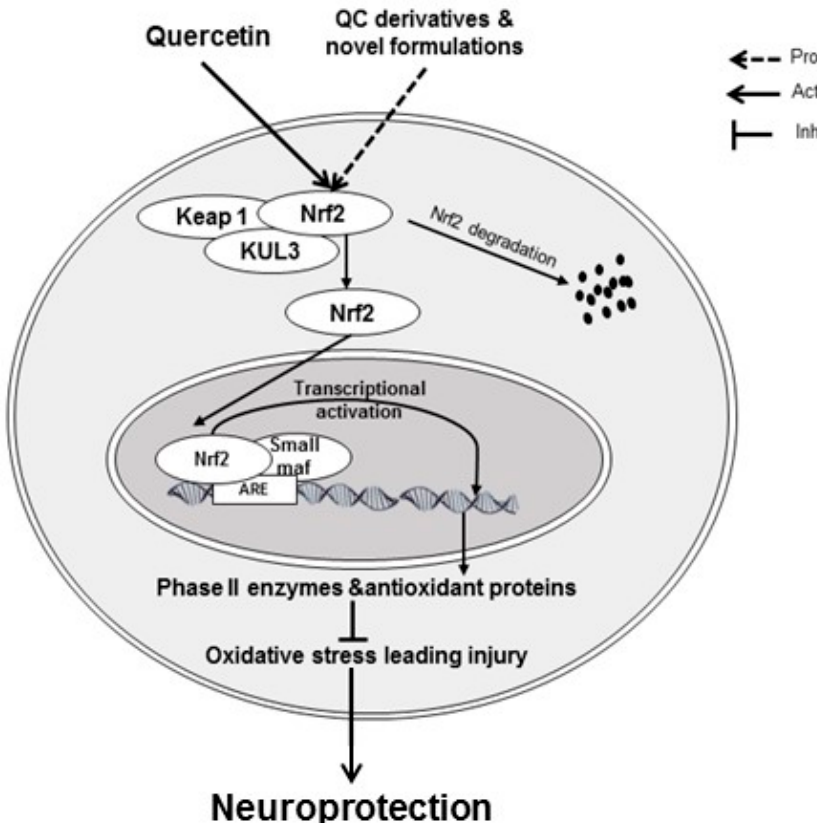
Figure 4. QC prevents oxidative stress leading to damage by activating the Nrf2 pathway. QC-mediated Nrf2 activation leads to transcriptional activation of antioxidant response elements. This activation results in prevention against oxidative damage and ultimately leads to amelioration of cognitive impairment. Keap1: Kelch-like ECH-associated protein 1; Nrf2-ARE: Nuclear factor erythroid 2.